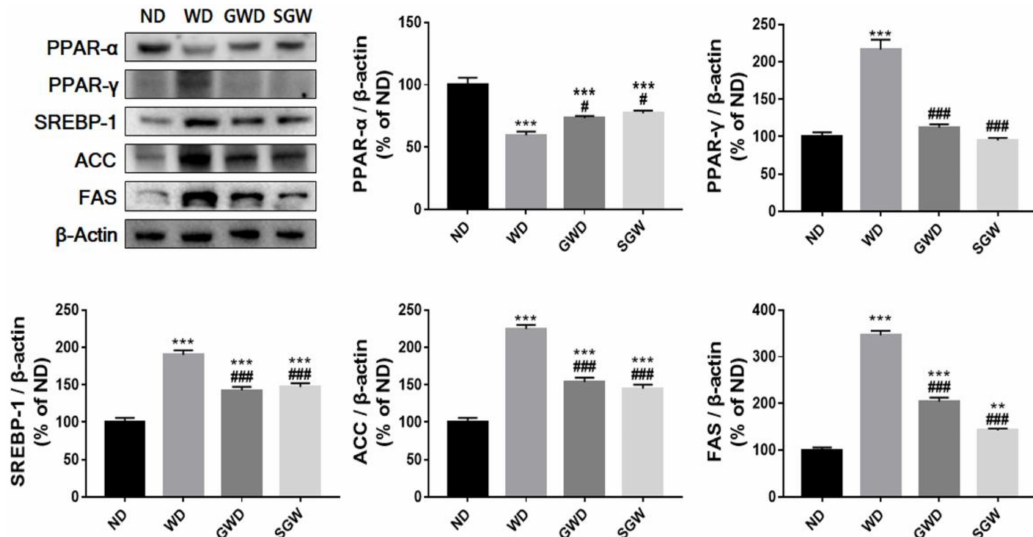
Figure 4. Diet-induced change of lipid metabolism in liver. Band intensities were normalized to those of β -actin and bar values are presented as the mean percentage of ND ± SEM of three independent experiments (** p < 0.01, *** p < 0.001 vs. ND; # p < 0.05 and ### p < 0.001 vs. WD).